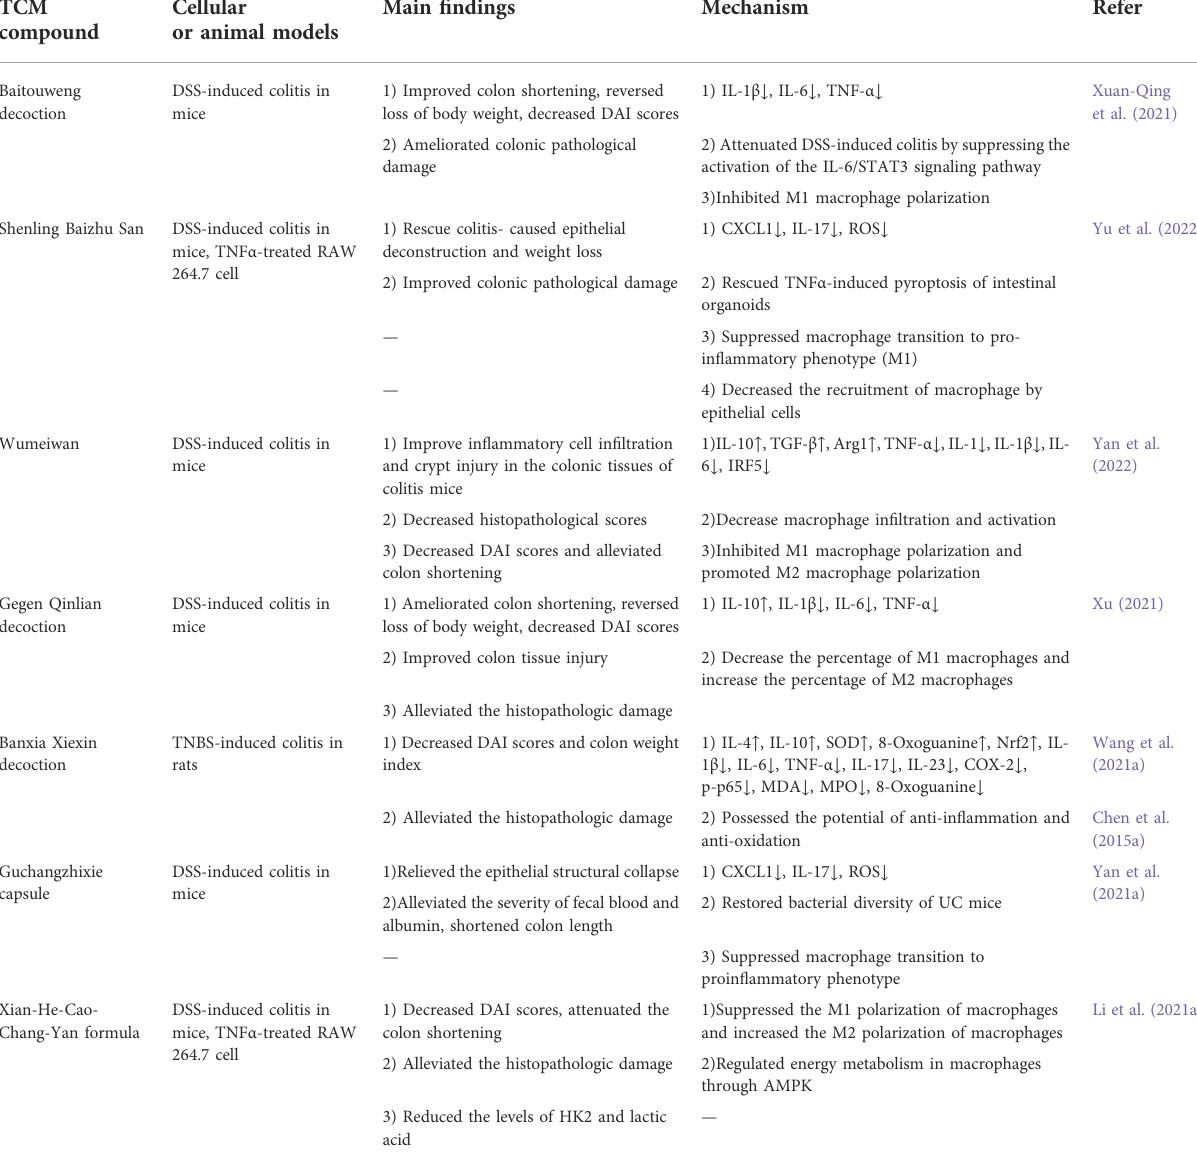
TABLE 1 TCM compound alleviates UC by regulating macrophage